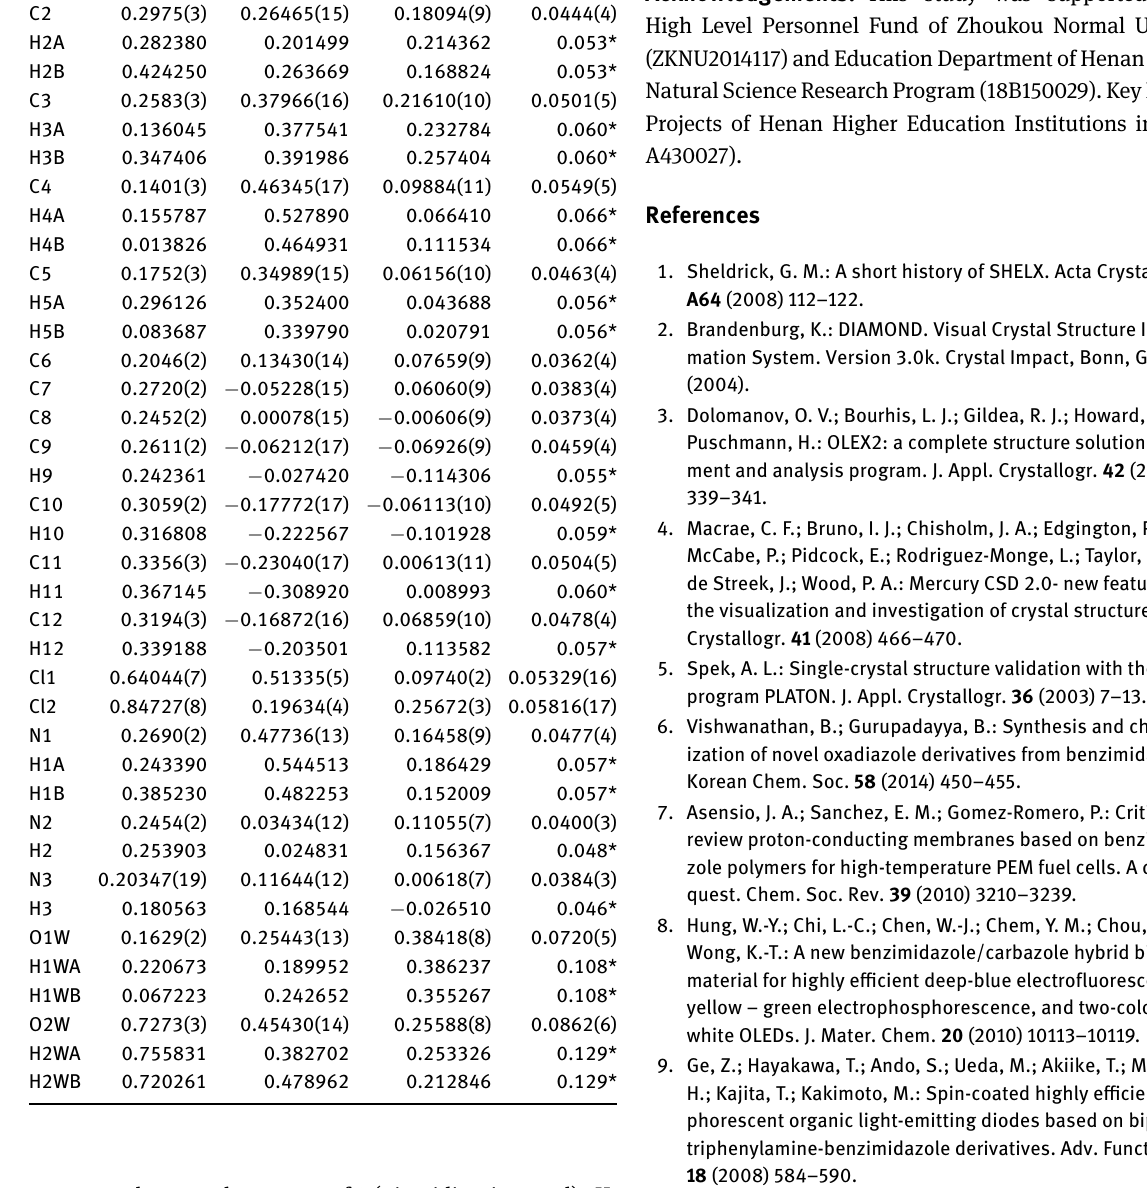
we report the crystal structure of 2-(piperidin-1-ium-4-yl)-1 H -